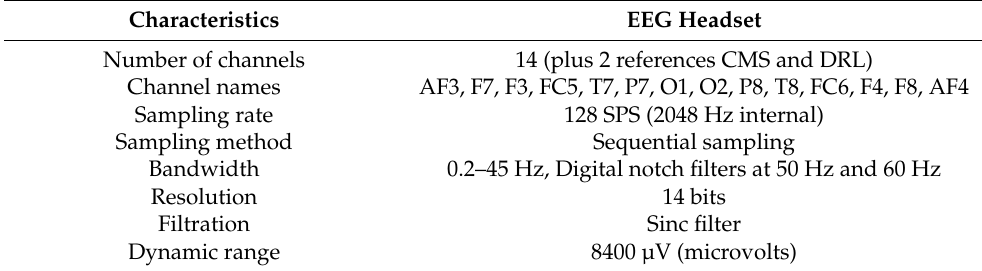
Figure 3. Location of the Emotiv EPOC + helmet of the International System (10–20) [58]. Table 1. The characteristics of the Emotiv EPOC +